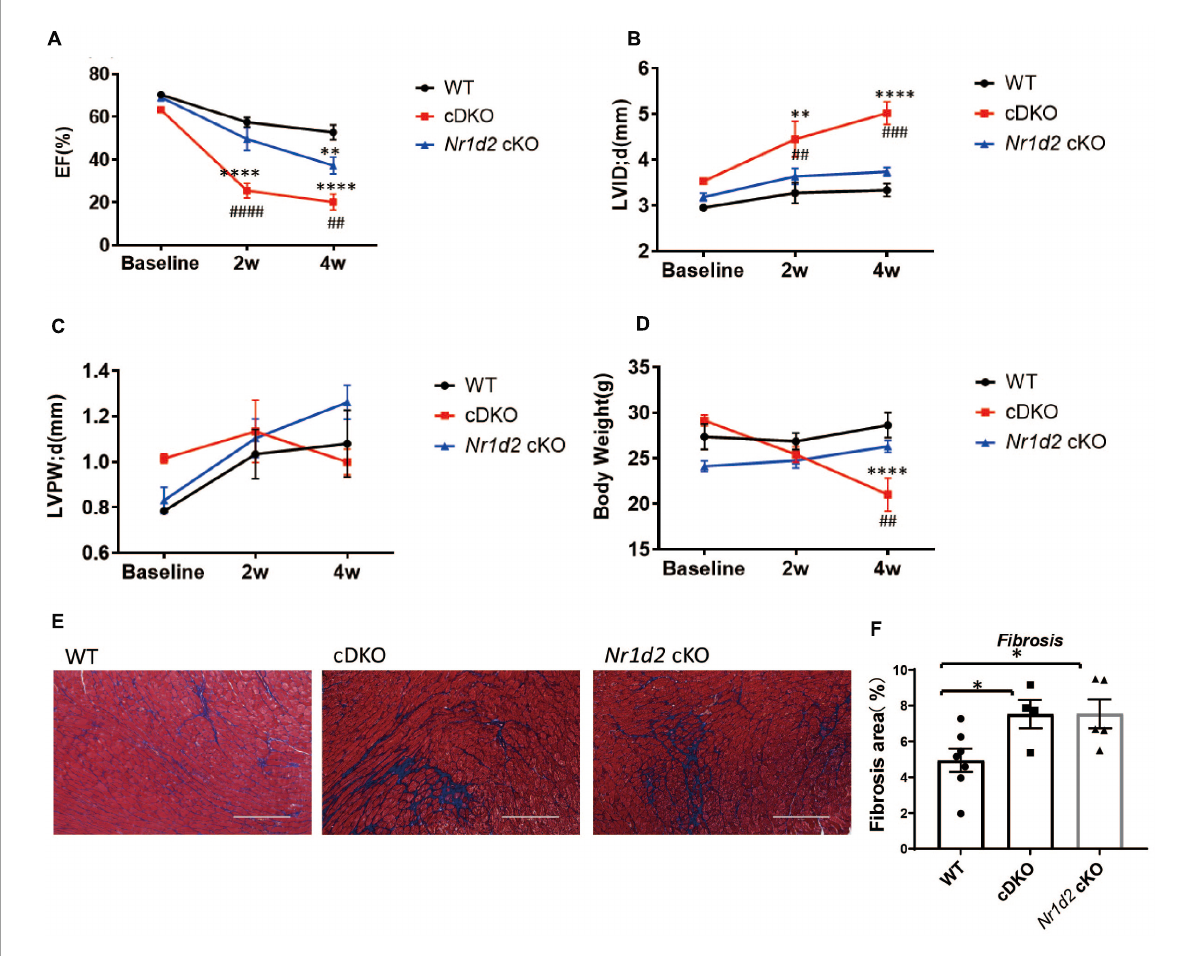
FIGURE1 Deficiency of REV-ERB α / β or REV-ERB β in cardiomyocytes exacerbates heart failure upon pressure overload. (A–C) Echocardiography analysis of ejection fraction (EF), LVID;d (left ventricle internal diameter; end-diastole), and LVPW;d (left ventricle posterior wall thickness; end-diastole) at __ weeks after TAC. (D) Body weight in WT, cDKO, and Nr1d2 cKO mice. (E,F) Representative images and quantification of fibrosis area by Masson’s trichrome staining at 4 weeks after TAC. WT n = 10, cDKO n = 6, Nr1d2 cKO n = 5. Data are shown as mean ± S.E.M. ## p < 0.01, ### P < 0.001, #### P < 0.0001, ∗∗ p < 0.01, ∗∗∗ P < 0.0001 by two-way ANOVA, ∗ indicates comparison to WT, # indicates comparison to cDKO. Tukey’s test was used for multiple comparison